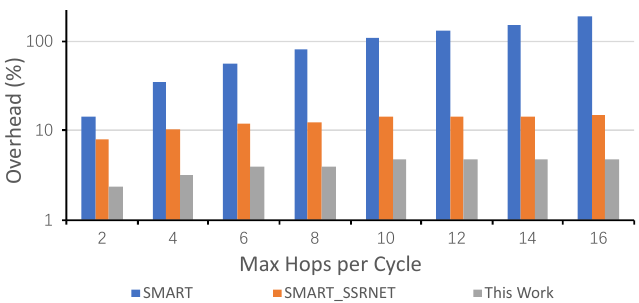
Figure 8. Wire Overhead. The wire overhead is calculated the flit width which is 128-bit in our